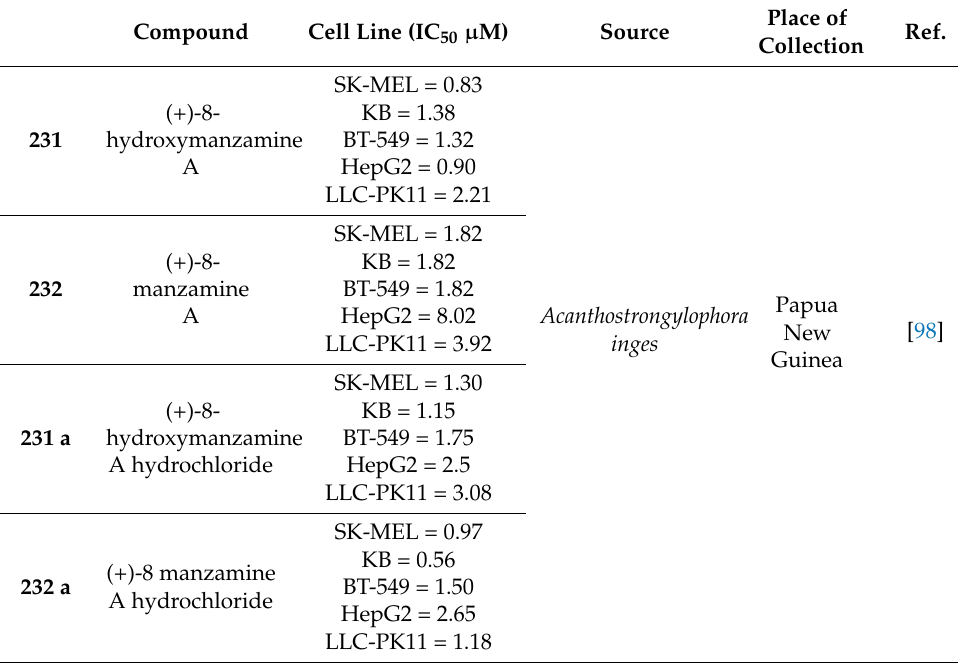
Table 18. Cytotoxic activity of manzamine